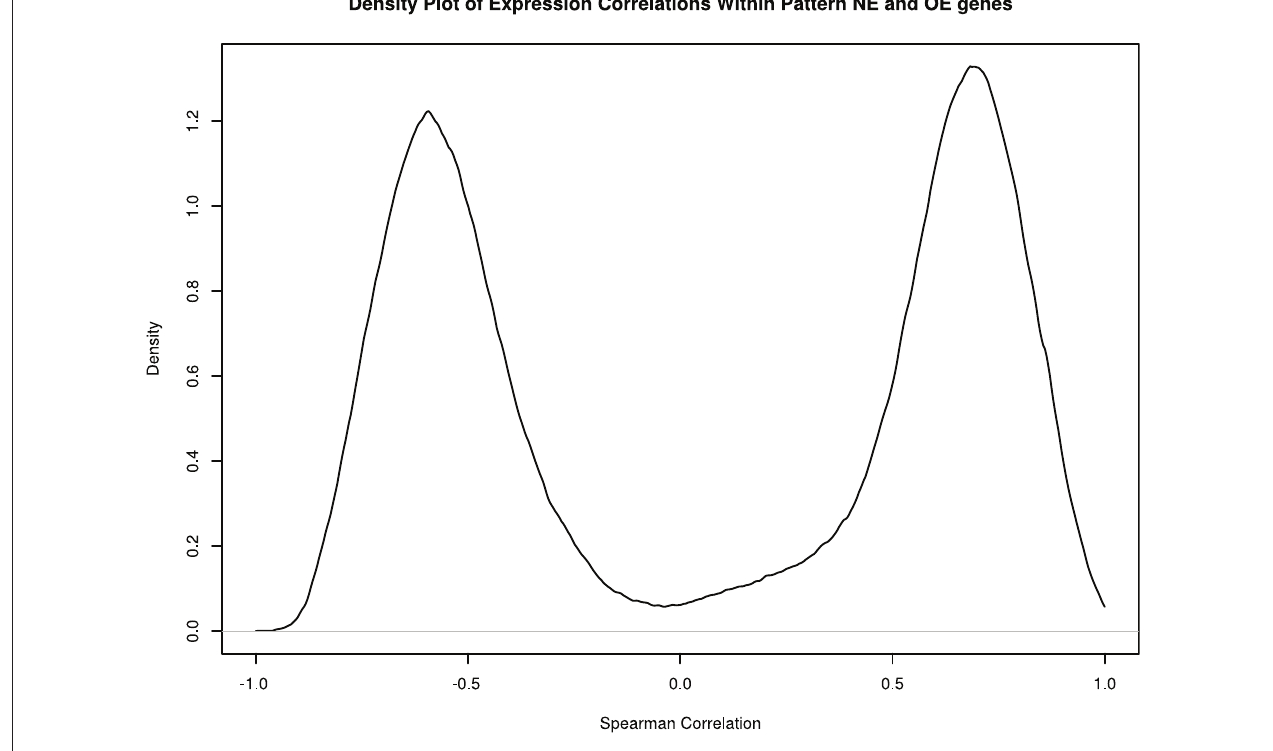
Figure A1 | Density plot of expression correlations within pattern Ne and Oe